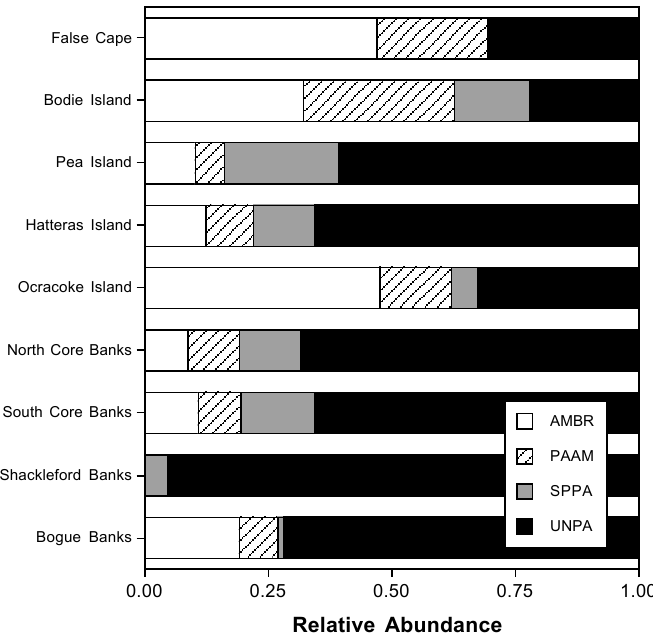
Figure 3. Distribution and relative abundance (proportional cover; percent cover per total percent cover of all functional groups) of plant functional groups (grasses, forbs, vines, and shrubs / trees) found in foredunes of the Outer Banks islands, USA (see Table S3A for statistics). Species richness for each island was the following: False Cape = 15 species, Bodie Island = 29 species, Pea Island = 10 species, Hatteras Island = 32 species, Ocracoke Island = 16 species, North Core Banks = 18 species, South Core Banks = 20 species, Shackleford Banks = 19 species, and Bogue Banks = 21 species. A plant species list for each functional group is given in Table S2. Diversity 2019 , 11 , x FOR PEER REVIEW